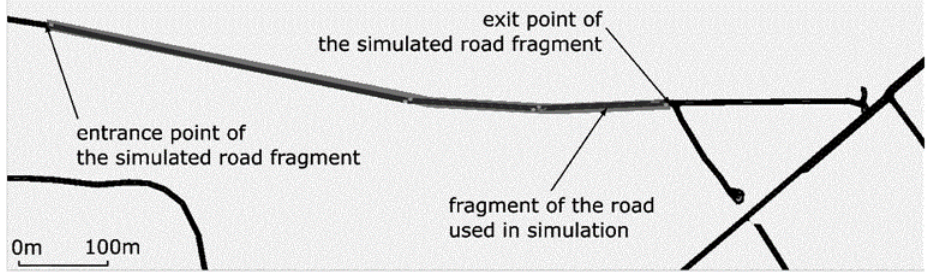
Figure 1. The geometry of the road used for the simulation.